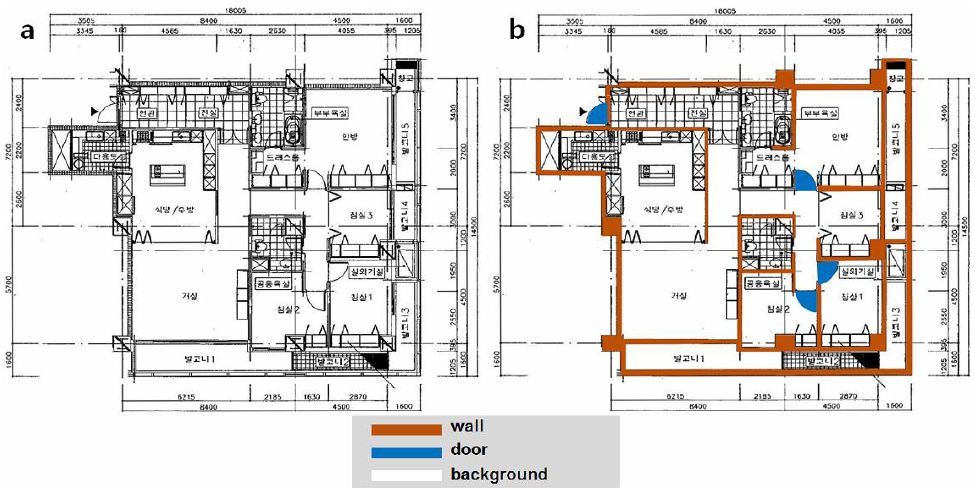
Figure 7. Examples of pixel-wise ground truth generation: ( a ) source image; ( b ) ground truth.